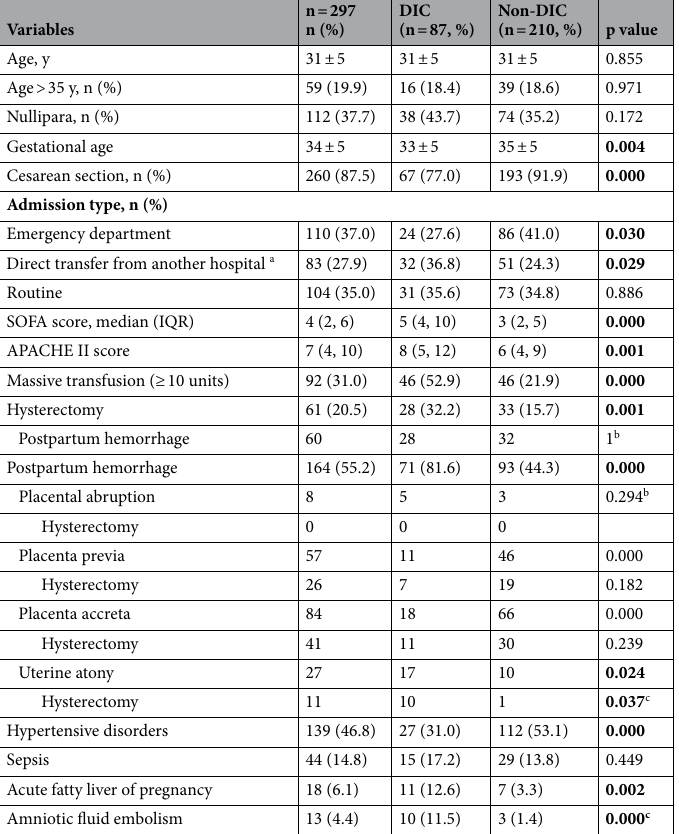
Table 1. The demographics of patients admitted to the ICU for obstetric diseases from 2008 to 2016. Significant values are in bold. IQR, interquartile range; SOFA, Sequential Organ Failure Assessment; MODS, multiple organ dysfunction syndrome. a Indicates that patients who were transferred directly to ICU wards from another hospital. b Represents Fisher’s exact test. c Represents continuity